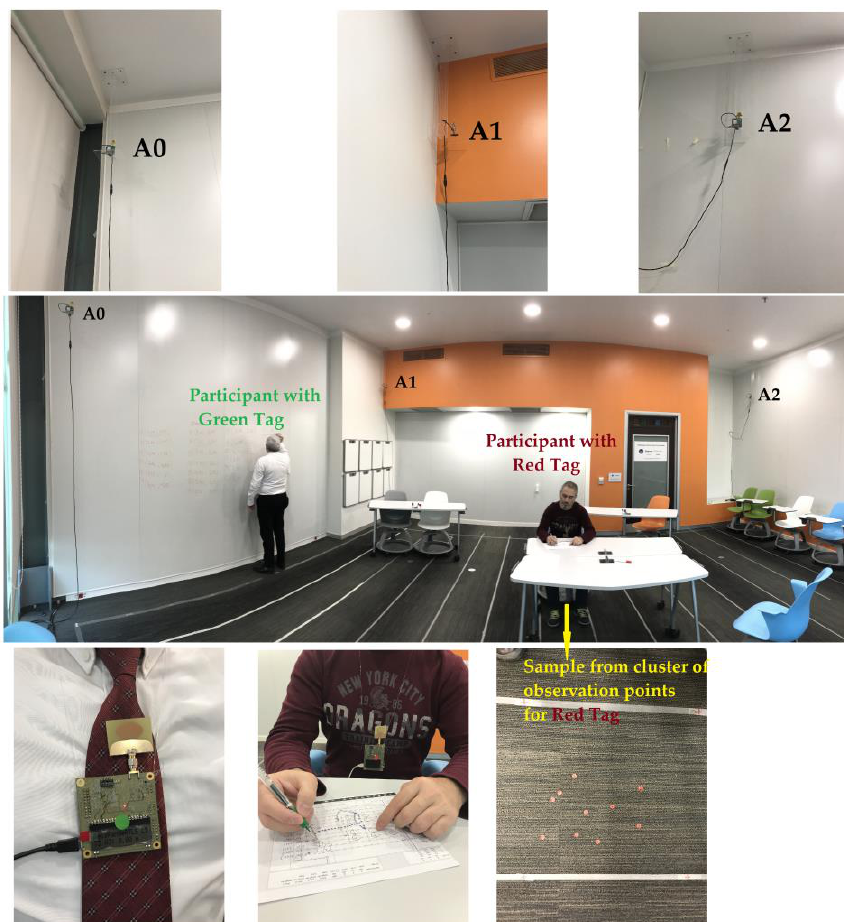
Figure 7. Introduction of the custom-designed ceiling system, the test bed setup with two tags (red and green), three anchors (A0, A1 and A2) and marked locations for each participant wearing a tag. Both participants stayed together in the testbed for three minutes for each location providing 180 samples for each marked location adding up to a total of 4680 (26 test points × 180 samples) location measurements collected. Three points, all from the green tag, were out of the test area, but we still included them in our tests to understand how the UWB system behaves for points that are outside of the test area.